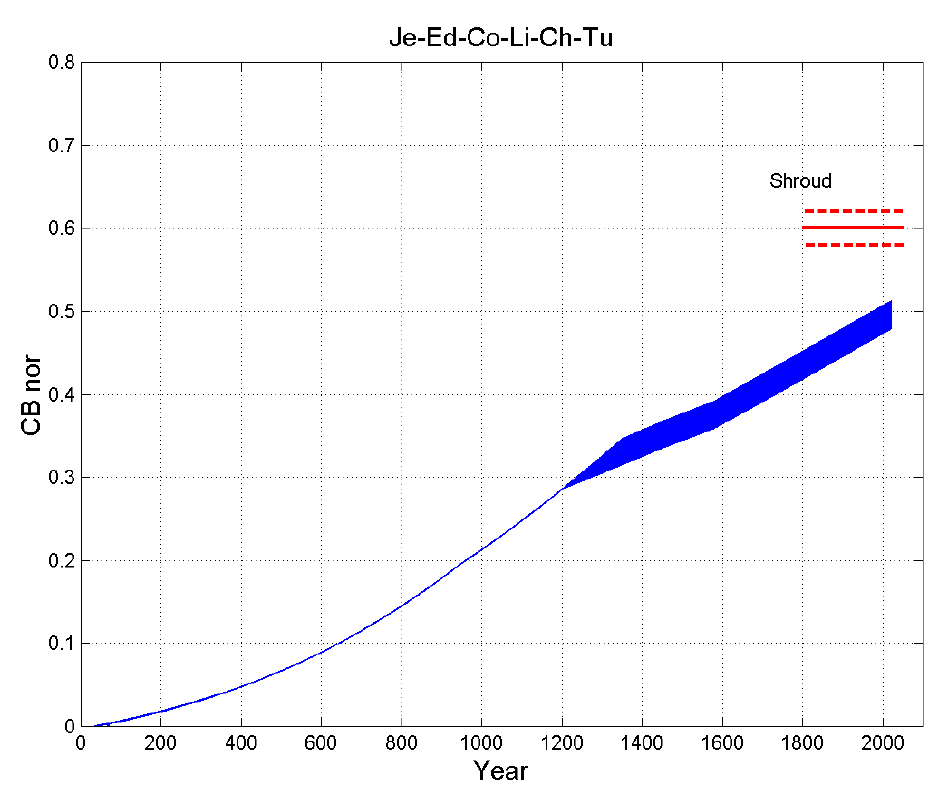
Figure 6. 𝐶𝐵 (cid:3041)(cid:3042)(cid:3045) versus year in the Jerusalem–Edessa–Constantinople–Lirey–Chambéry–Turin path Figure 6. CB nor versus year in the Jerusalem–Edessa–Constantinople–Lirey–Chamb é ry–Turin path 2 (Tables 1 and 2, Figure 1) until the year 2021. Each curve assumes a different arrival year in Europe, t Eu , randomly generated from a uniform distribution in the interval 1204 ≤ t Eu ≤ 1354. The upper curve assumes t Eu = 1354, while for the lowest curve t Eu = 1204. In 2021, CB nor , min = 0.485, CB nor , max = 0.519, and CB nor , ave = 0.502. The continuous red line indicates the average experimental CB nor = 0.60 measured for the Shroud [9]; the dashed red lines indicate ± 1 standard deviation bounds due to measurements